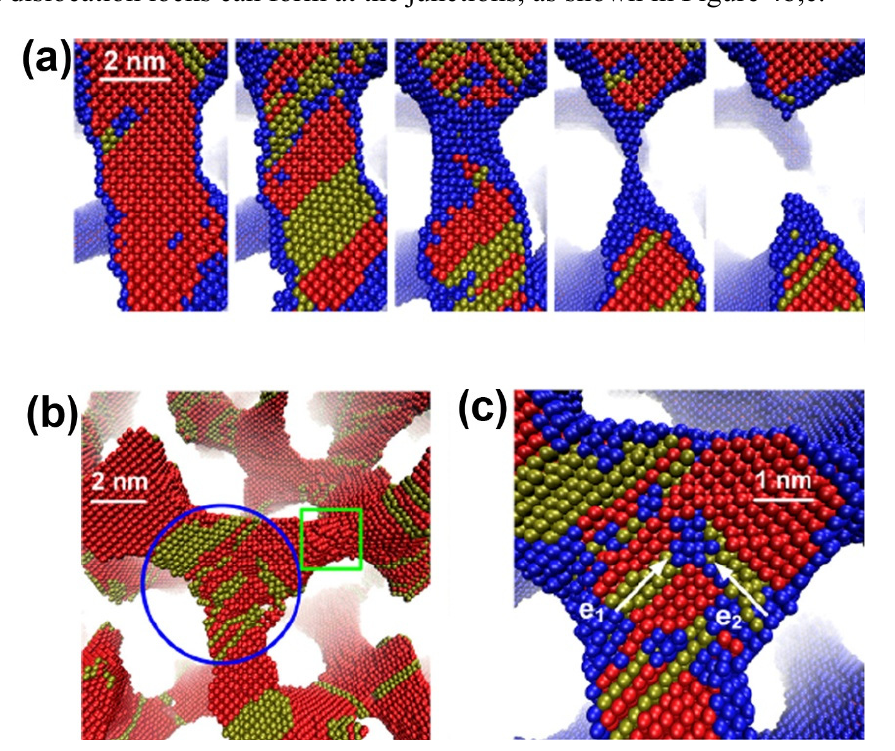
Figure 4. Deformation mechanism of nanoporous gold under uniaxial tension: ( a ) rupture of a ligament; ( b ) dislocation nucleation; and ( c ) a dislocation lock formation in a junction. Reproduced with permission from Reference [87]. (Copyright AIP Publishing LLC